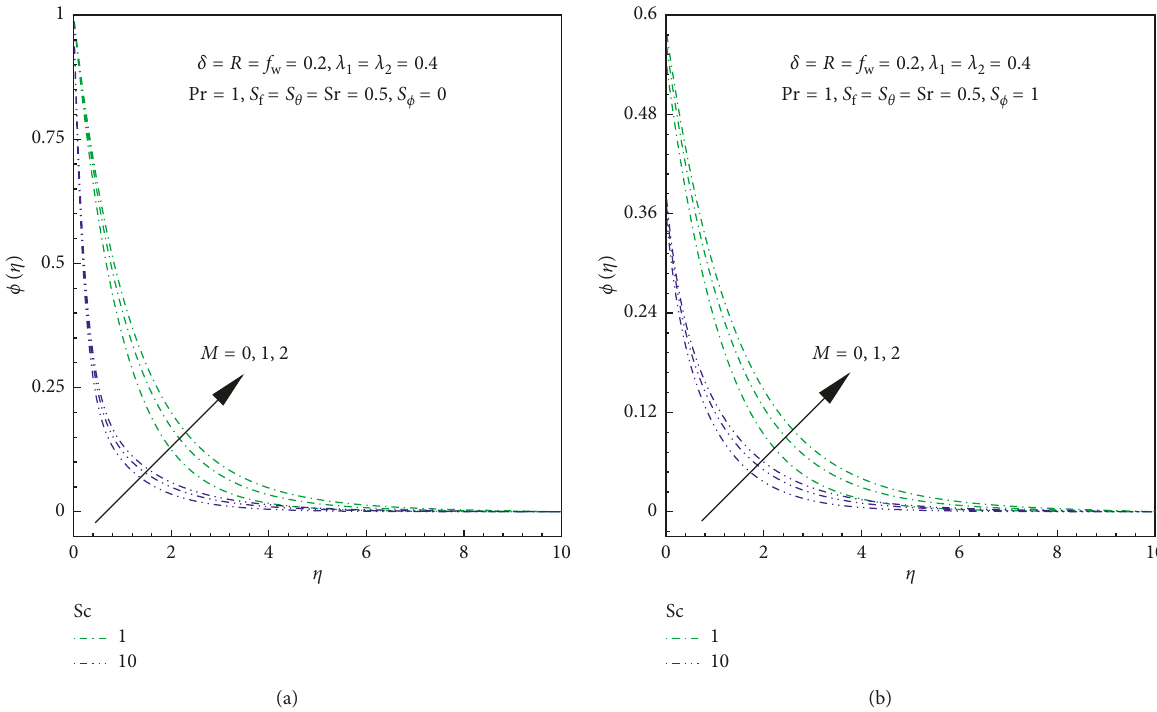
Figure 6: Effects of M and Sc on dimensionless concentration. (a) No thermal slip. (b) With thermal slip.